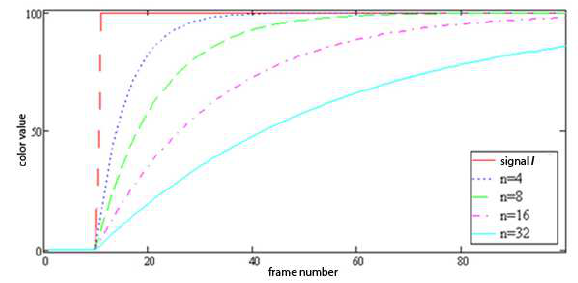
Figure 1: Accumulated pixel m n ( k ) for different α n